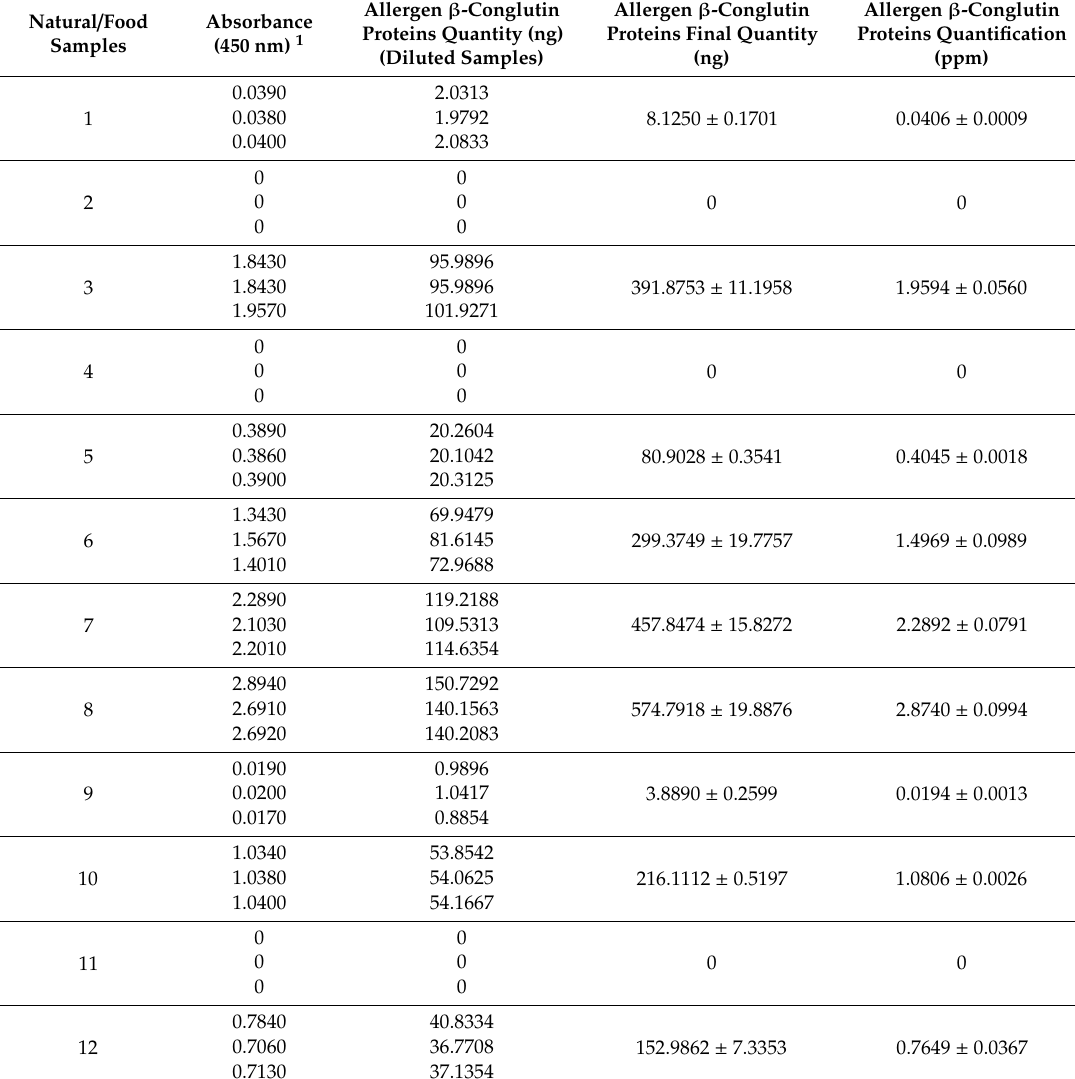
Table 2. Detection and quantification of the NLL main seed allergen β -conglutin (Lup an 1) in